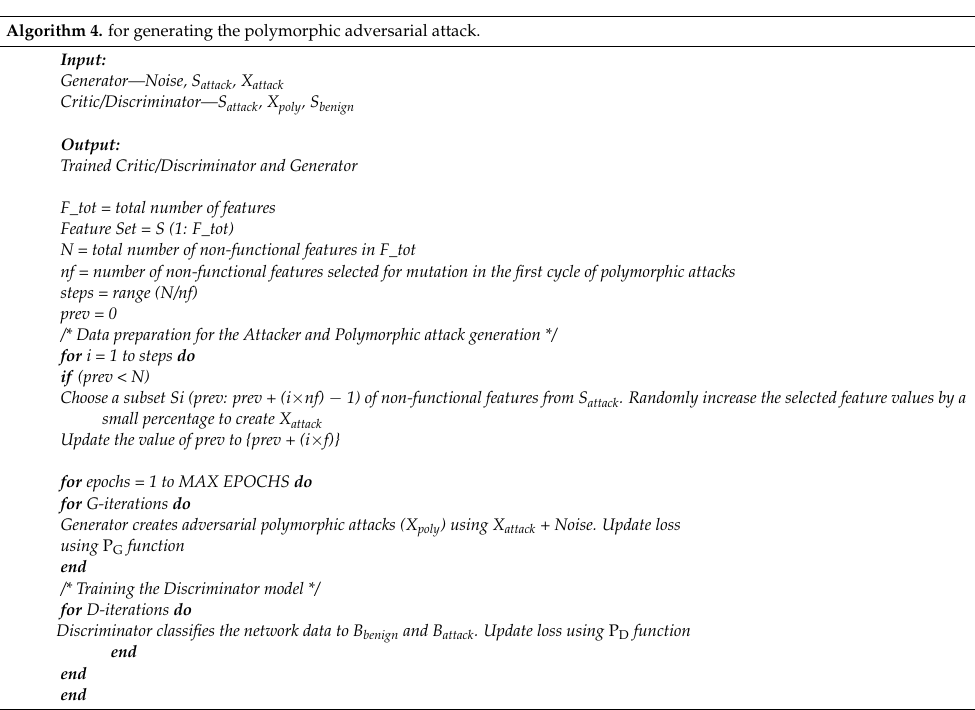
Algorithm 4. for generating the polymorphic adversarial